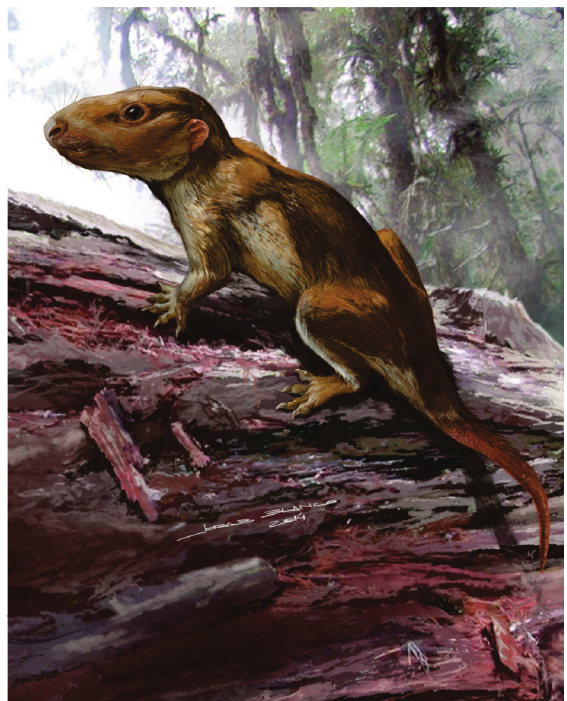
Fig. 8 - Artistic reconstruction of Botucaraitherium belarminoi gen. et sp. nov., by Jorge